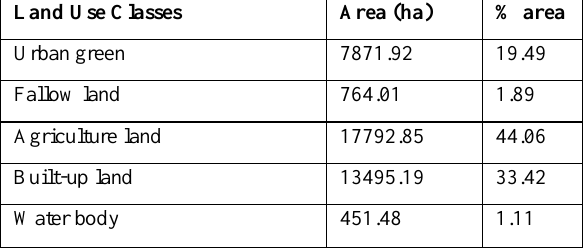
Table 1: Land Use/ Land Cover 2008